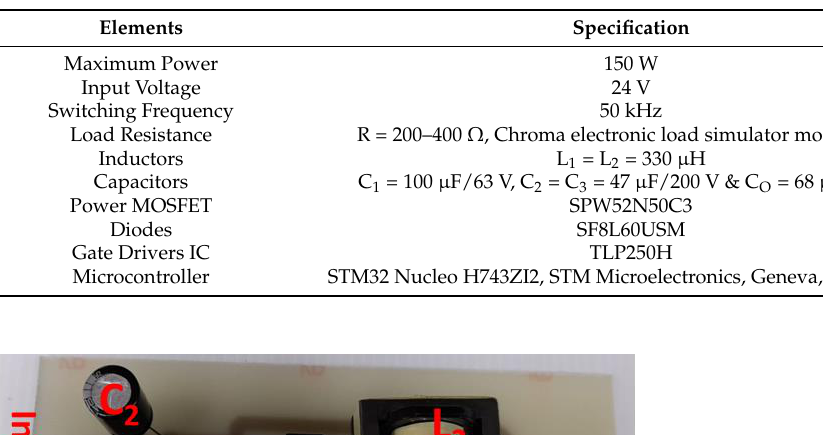
Table 3. Design specification of converter I (adapted from [31]).